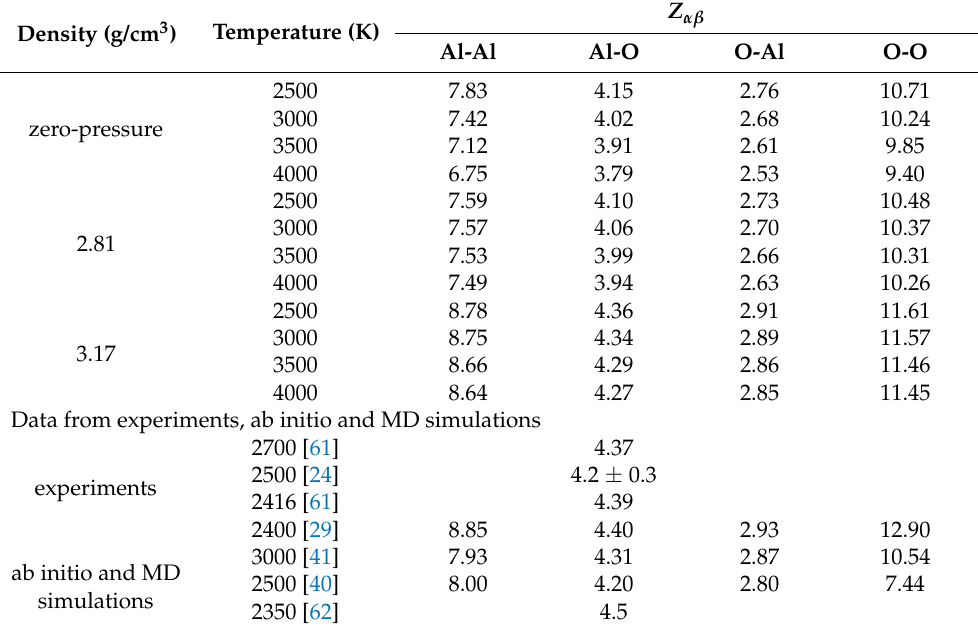
Table 3 demonstrated that for the atom pairs of Al-O, the average coordination num- bers ( Z αβ ) were approximately located at ~4, consistent with the experimental, ab initio and MD simulation findings. For all the atom pairs of α - β , Z αβ increased along with the density at each temperature. However, when at zero pressure or a fixed density, Z αβ roughly decreased as the temperatures rose from 2500 K to 4000 K. Table 3. The average coordination number ( Z αβ ) for liquid alumina from this MD simulation and the data from experiments and ab initio